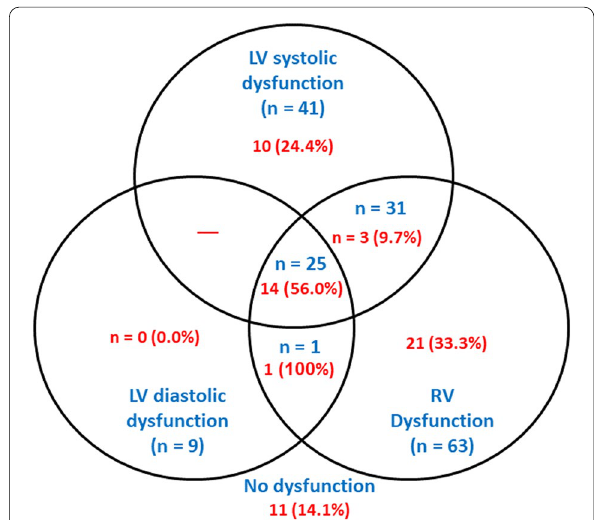
(with 30-day mortality expressed in red-colored font)